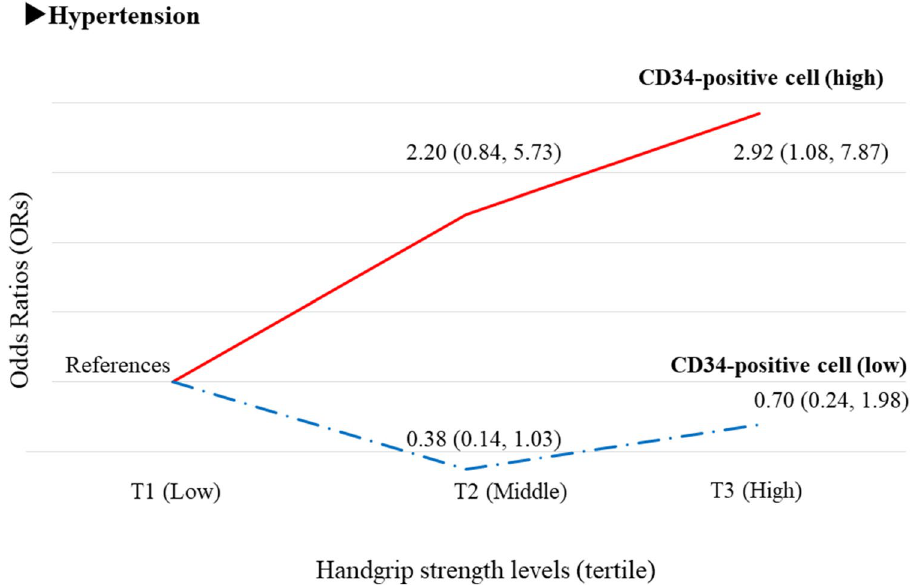
Figure 6. Associations between handgrip strength levels and hypertension 32 . T1: The lowest tertile level. T2: Middle tertile level, T3: The highest tertile